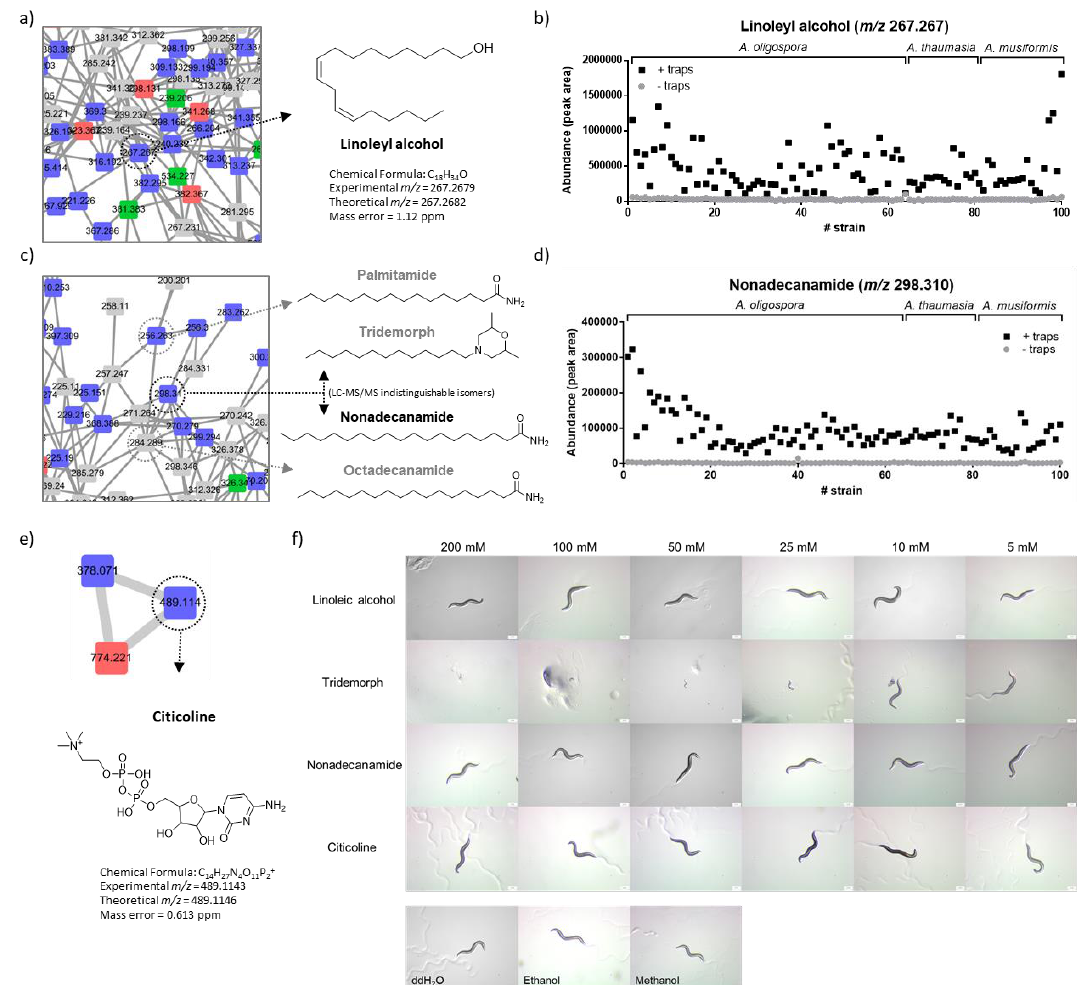
Figure 5. The identified fungal metabolites enriched in the predatory stage. Three nodes enriched in the predatorystagewereidentifiedandtestedfortheirnematicidalactivity. Linoleylalcohol: ( a )Highlighted molecular network with linoleyl alcohol. ( b ) The abundance of linoleyl alcohol in each Arthrobotrys strain before and after the formation of the traps. Nonadecanamide: ( c ) Highlighted molecular network with the node with m / z 298.310, which was identified as nonadecanamide. Tridemorph, a structural isomer of nonadecanamide with the identical LC–MS / MS information, was also shown. ( d ) The abundance of nonadecanamide in each Arthrobotrys strain before and after the formation of the traps. Citicoline: ( e ) The molecular cluster with citicoline (from the aqueous extract). ( f ) The nematicidal activity test of the identified metabolites. Negative control experiments using pure solvent were shown. Only tridemorph showed significant inhibition activity against